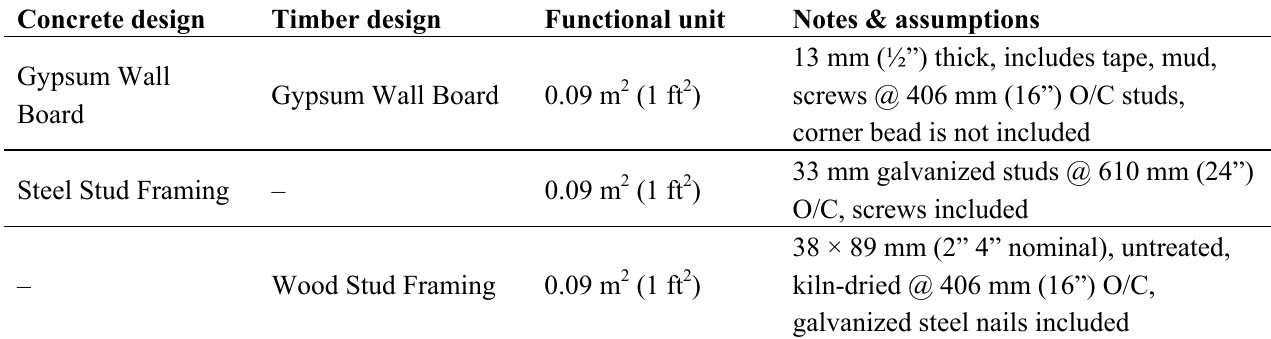
Table 2. Building materials and their corresponding functional